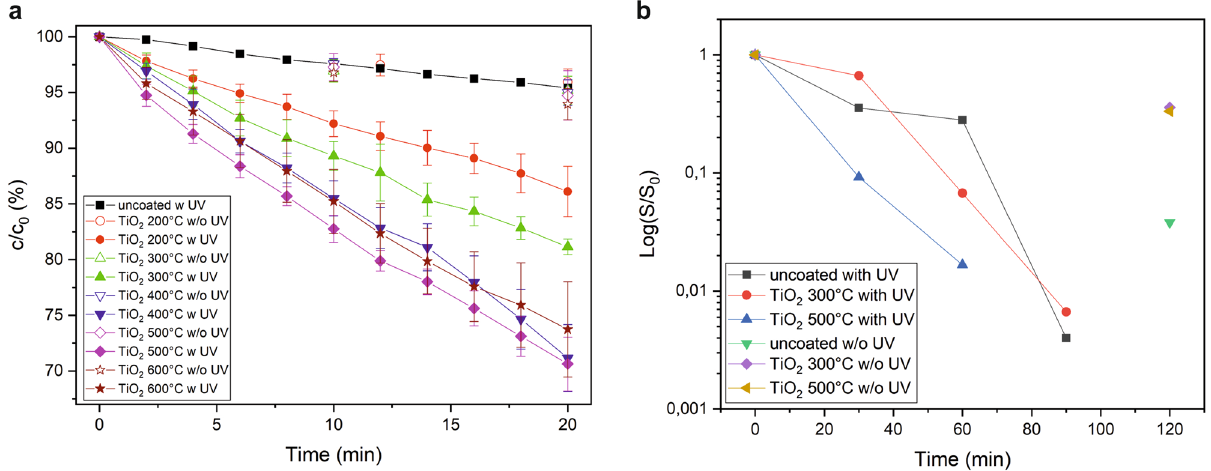
Figure 4. ( a ) Methylene blue degradation kinetics expressed as ratio between actual ( c ) and starting concentration ( c 0 ) versus time on neat and TiO 2 -coated FTO glass slides with and without 369 nm irradiation. Data points indicate the mean of three measurements and error bars denote the standard error of the mean. ( b ) Bacterial inactivation kinetics expressed as logarithm of survival rates versus time on neat and TiO 2 -coated FTO glass slides with and without UV-A irradiation. The data point of the TiO 2 500 ◦ C with UV sample at 90 minutes cannnot be shown in the logarithmic presentation since the survival rate approached zero. The drawn lines serve as guide to the